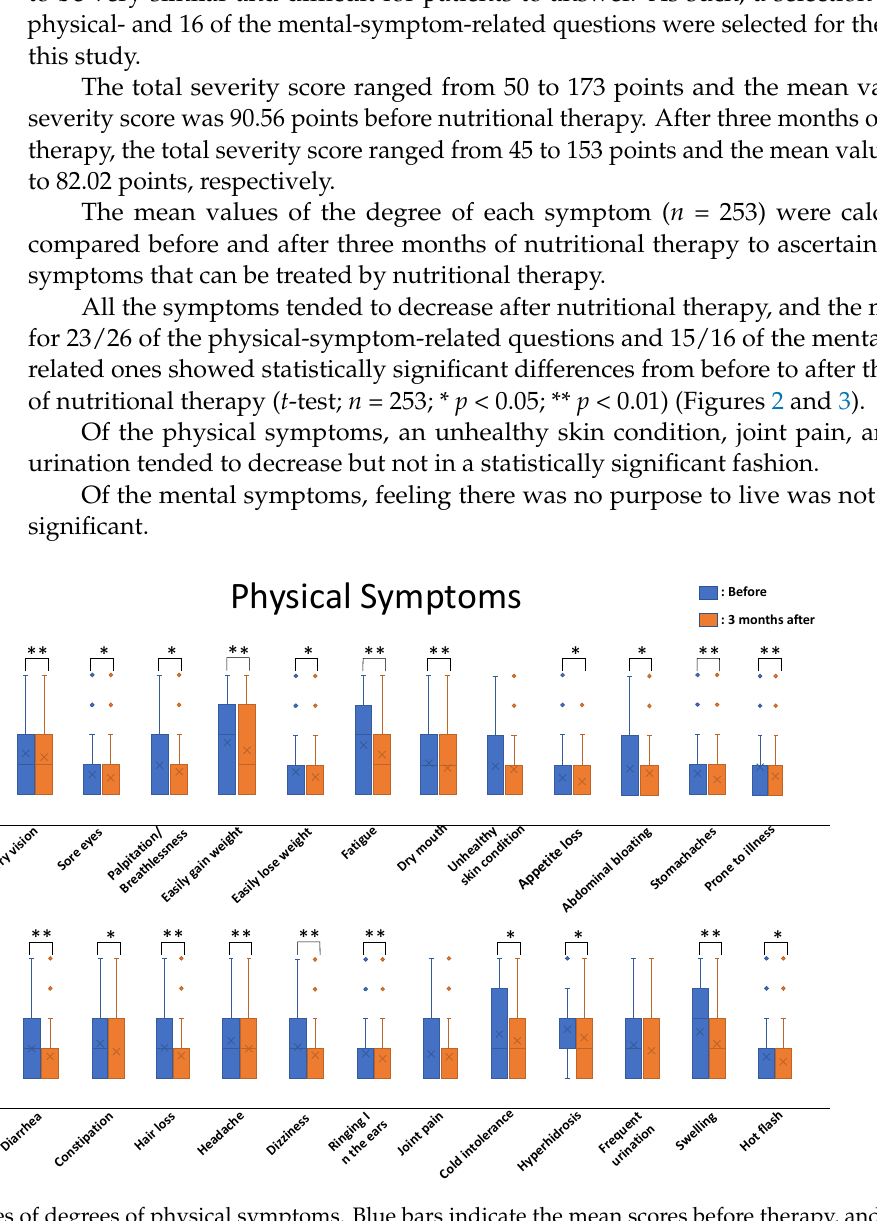
Figure 2. The mean values of degrees of physical symptoms. Blue bars indicate the mean scores before therapy, and orange bars indicate the mean scores after 3 months of nutritional therapy. Error bar indicates 2xSTDEV.S and Blue and Orange circles indicate outlier beyond 2xSTDEV.S. All symptoms tended to decrease, and the mean values for 23/26 of the physical symptoms showed statistically significant differences from before to after nutritional therapy ( t -test: n = 253; *: p ≤ 0.05; **: p ≤